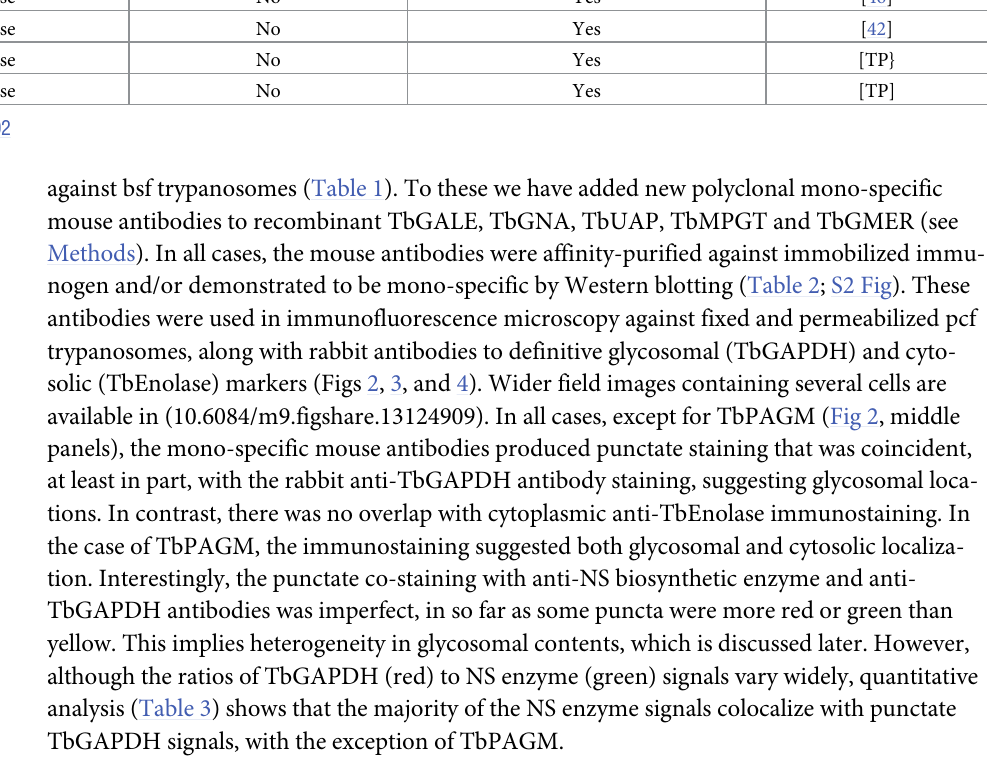
Table 2. Antibodies to nucleotide sugar biosynthetic enzymes used in this study. [TP] = this paper. Enzyme Antibody species